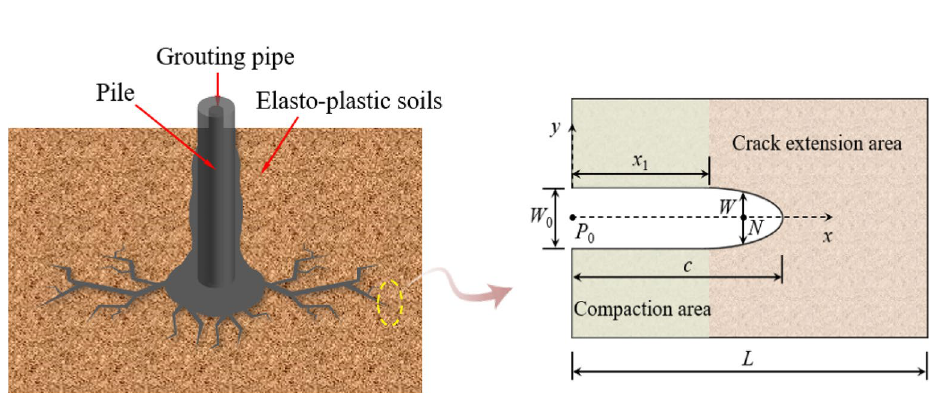
Figure 1. Crack propagation model of fracture